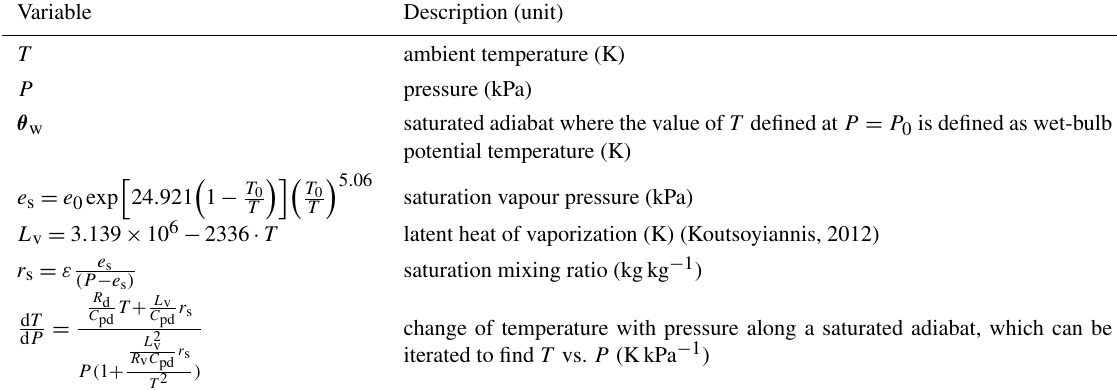
Table 2. Variable